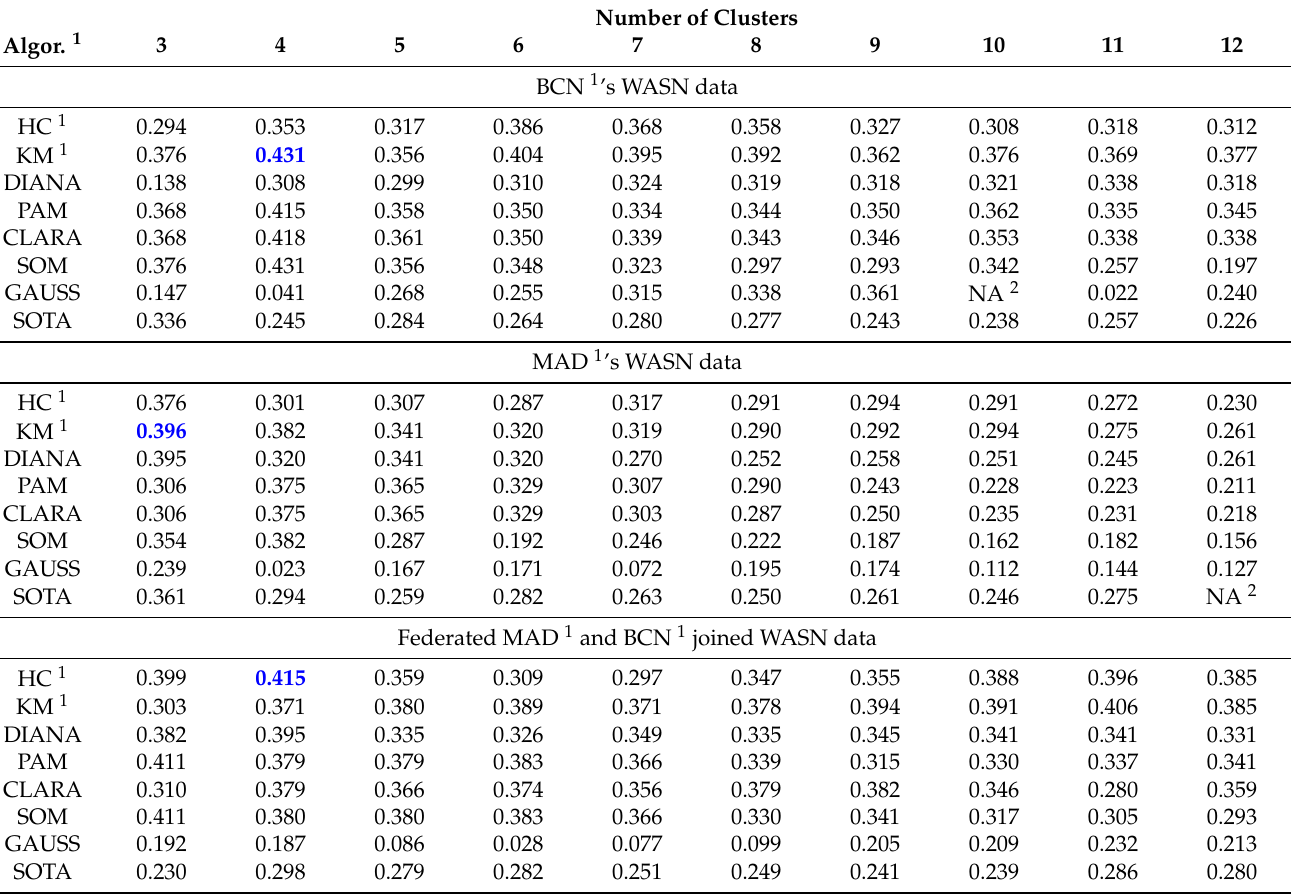
Table 5. Evaluation and comparison of clustering techniques over WASN data based on the Silhou- ette Width. Number of Clusters